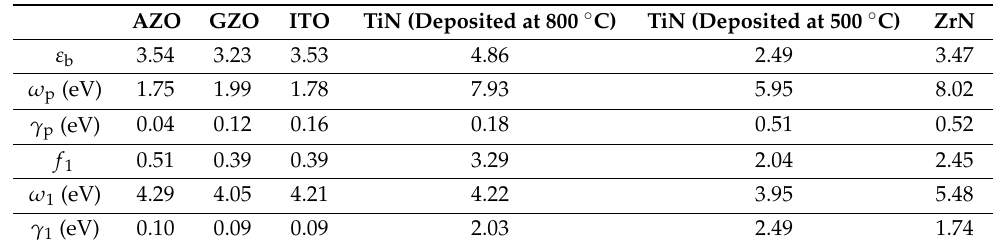
Table 1. Drude–Lorentz parameters of plasmonic materials obtained from experimental data. One may approximate the materials dielectric function by the complex dielectric